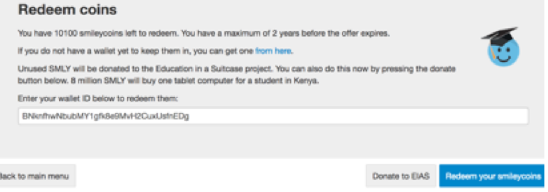
Fig. 7. Option of donating to Education in a